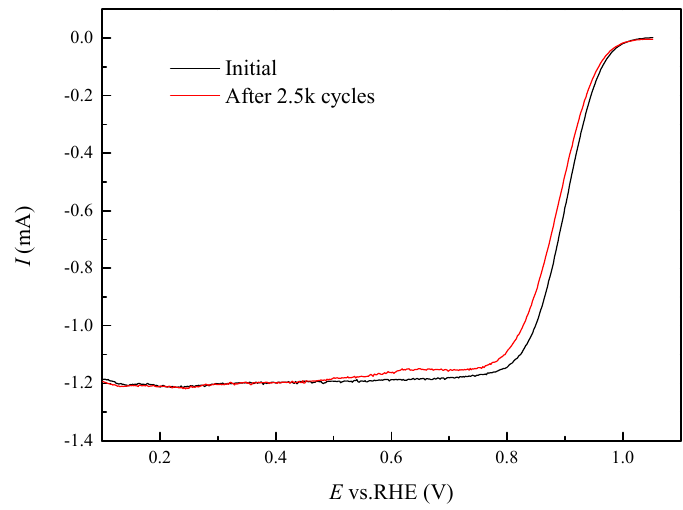
Figure 7. LSV curves of Pt/C before and after ADT.